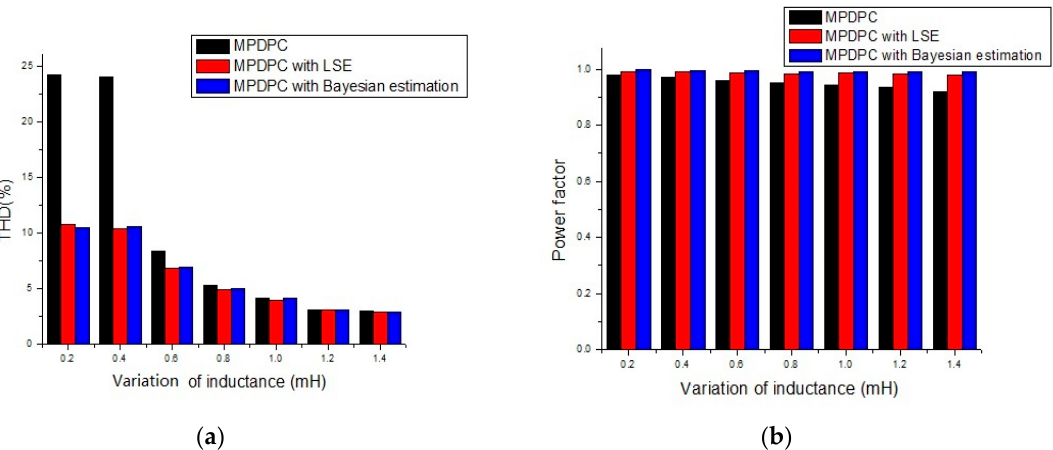
Figure 22. The Bar diagram of performance index under three kinds of MPC control scheme. ( a ) The THD of input current; ( b ) the power factor of rectifiers.